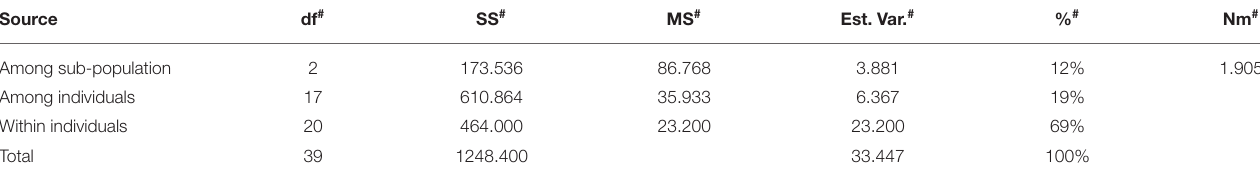
TABLE 6 | Analysis of molecular variance for white flesh, apple color, and pink flesh subgroups for within population, among population, and within individual variation.